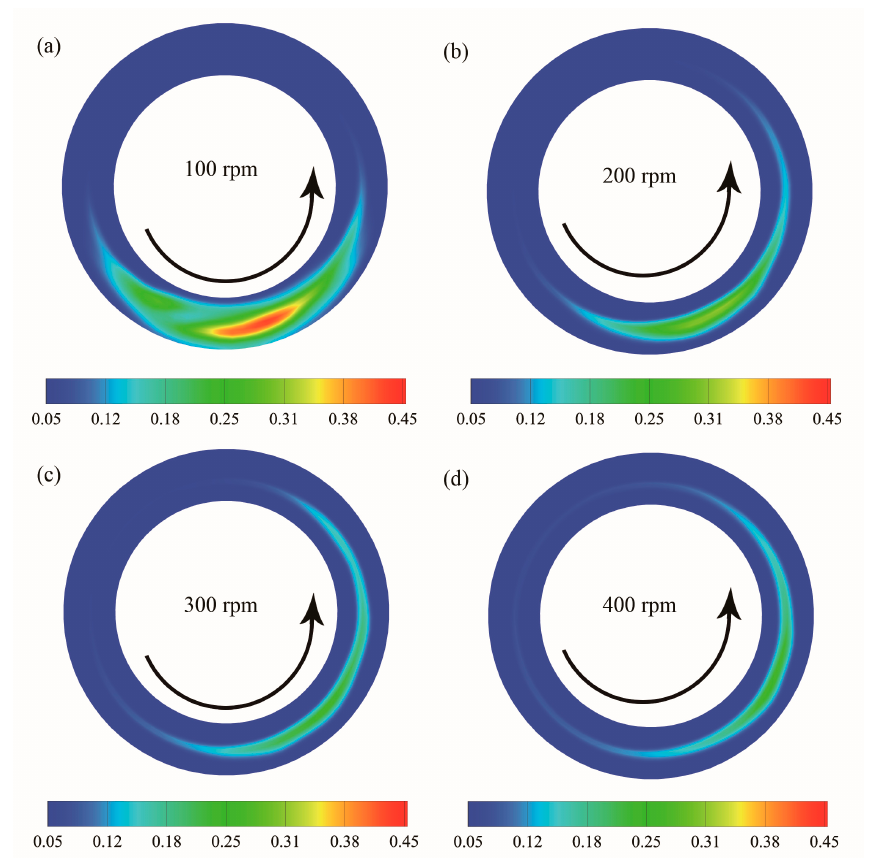
Figure 5. Contours of the cuttings volume fraction of different rotational speed: ( a ) 100 rpm; ( b ) 200 rpm; ( c ) 300 rpm; ( d ) 400 rpm.